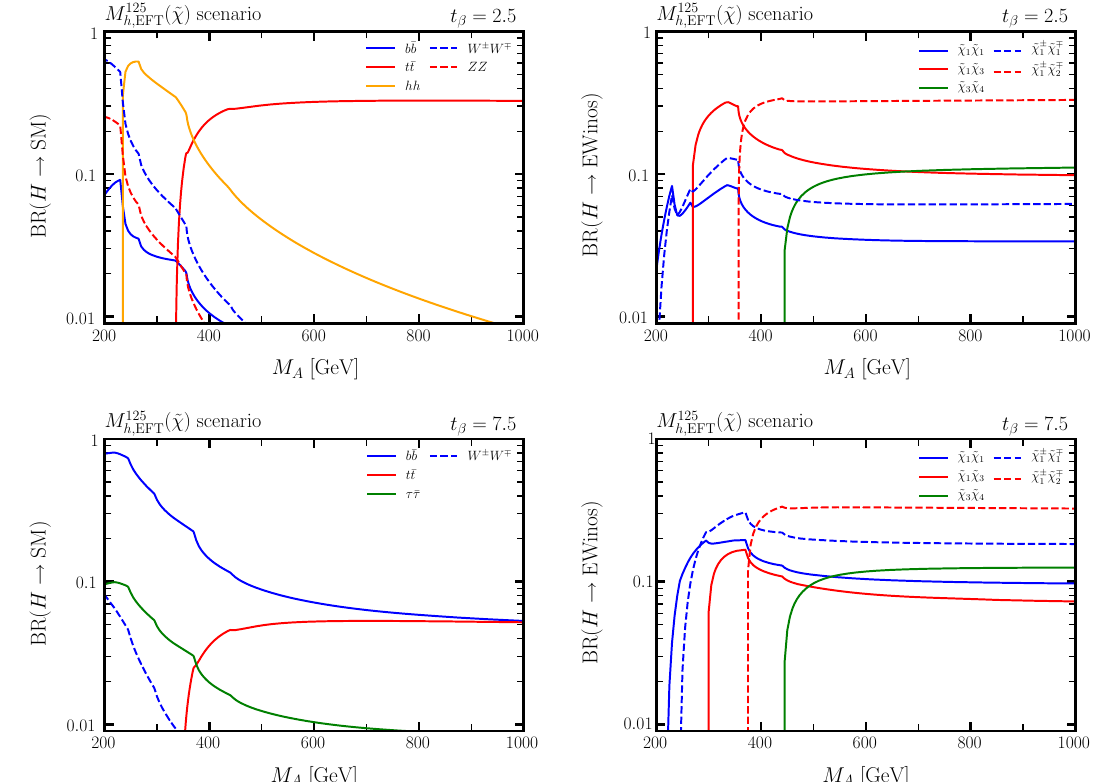
( ˜ χ) scenario as a function of M β = 2 . 5 A , for fixed tan h , EFT